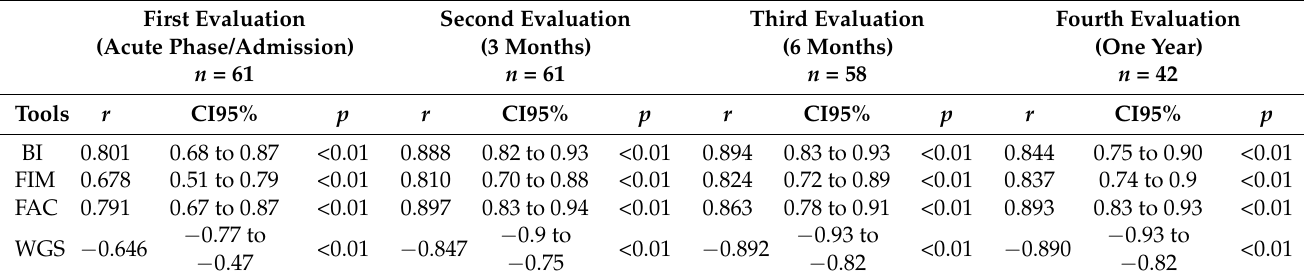
Table 4. Construct validity of postural assessment scale for stroke